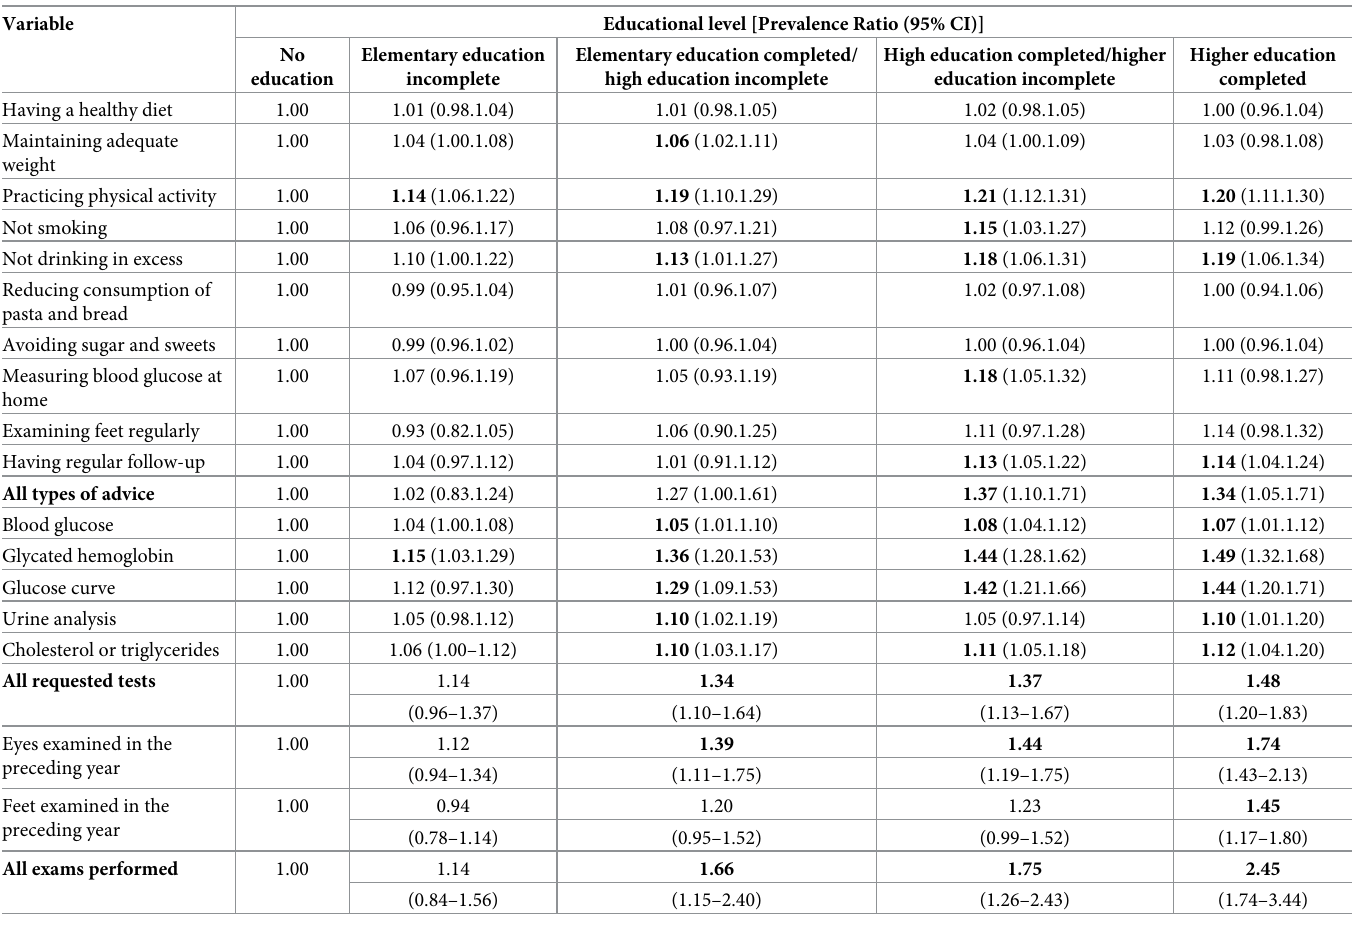
Table 2. Adjusted analysis of the care services offered to the people with diabetes mellitus, according to educational level, Brazil, 2019 (N =